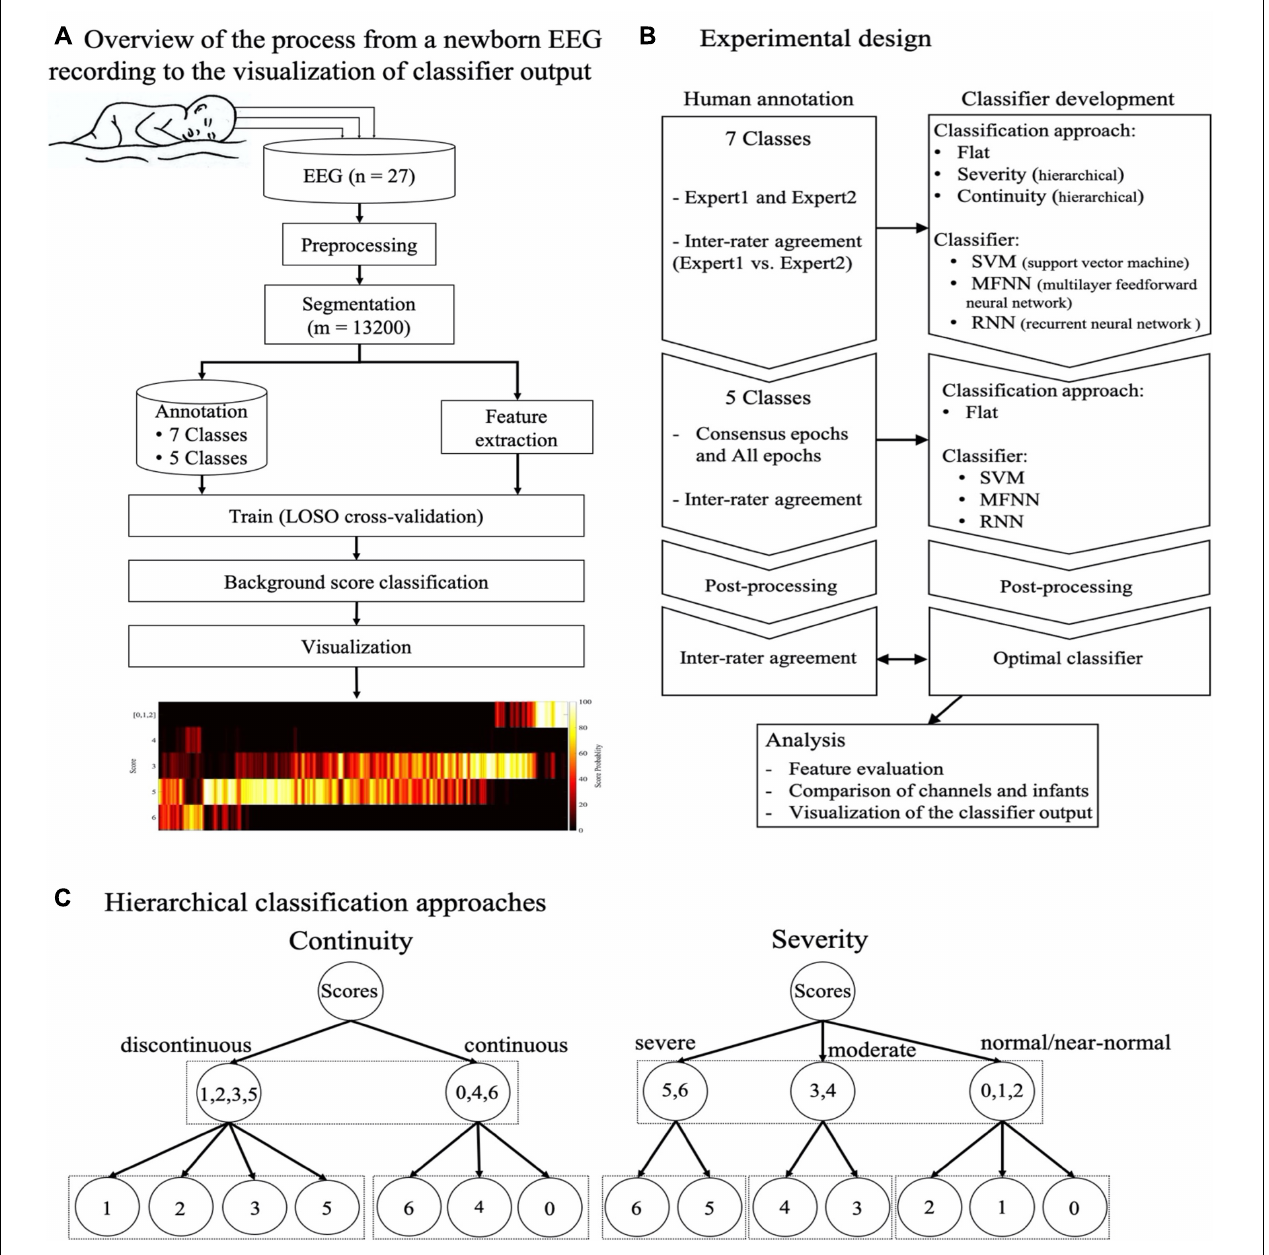
FIGURE 1 | The overall design of the present study. (A) The flow diagram shows the steps involved from the newborn EEG recording to annotation and training of the classifier, and finally a visualization of the classifier output. (B) Schematic overview of classifier experiments presented in this work. (C) Schematic overview of two hierarchical classification approaches, one based on EEG continuity (left) and the other based on the severity of EEG background (right). As opposed the flat classifier design, the hierarchical classifiers begin with an initial distinction between continuity (left) or severity (right), followed by classifying only subset of